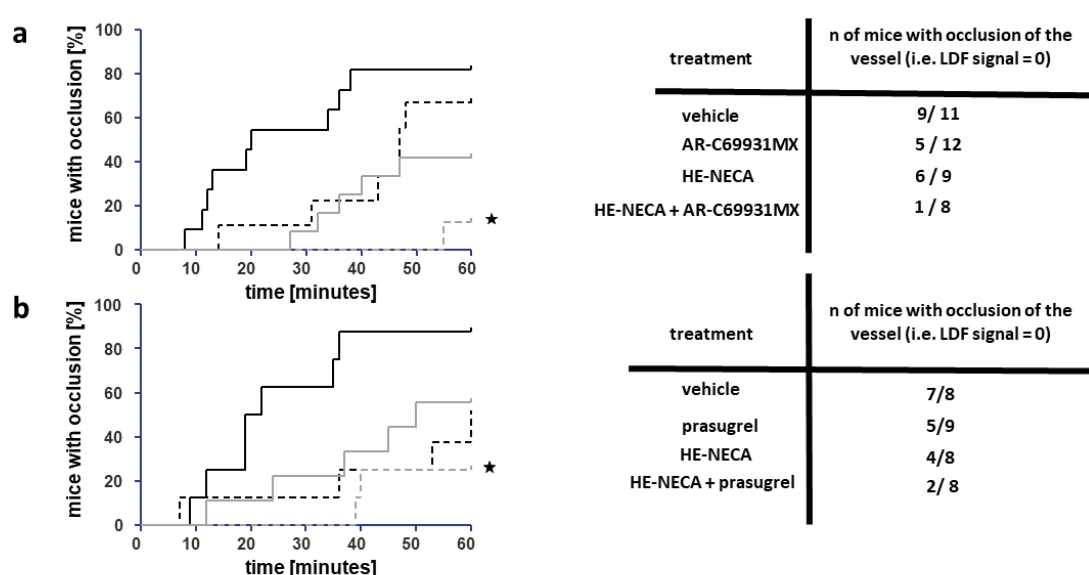
Figure 3. Effects of cangrelor and HE-NECA ( a ) or prasugrel and HE-NECA ( b ) applied alone or in a combination on occlusion induced with the use of FeCl 3 in the jugular vein in mice. Left panels show cumulative curves of the percentage of mice in which occlusion occurred in the function of time, solid black line: DMSO, black dashed line: HE-NECA, gray solid line: cangrelor ( a ) or prasugrel ( b ), gray dashed line: combination of HE-NECA and cangrelor ( a ) or prasugrel ( b ); n = 8–11. The significance of differences between curves was estimated with the use of log-rank test with the correction for multiple comparisons, * p < 0.05 (corrected). Right panels present ratios of animals in which total occlusion occurred. Significance of differences between the ratios were tested with the use of an exact Fisher t -test. The exact p -values are as follows: ( a ) vehicle vs. cangrelor p = 0.06024; vehicle vs. HE-NECA p = 0.39551; vehicle vs. a combination p = 0.00488; HE-NECA vs. a combination p = 0,03640; cangrelor vs. a combination p = 0,18731 and ( b ) vehicle vs. prasugrel p = 0.18326; vehicle vs. HE-NECA p = 0.14103; vehicle vs. combination p = 0.02028; HE-NECA vs. a combination p = 0.30420; prasugrel vs. a combination p = 0.21781.